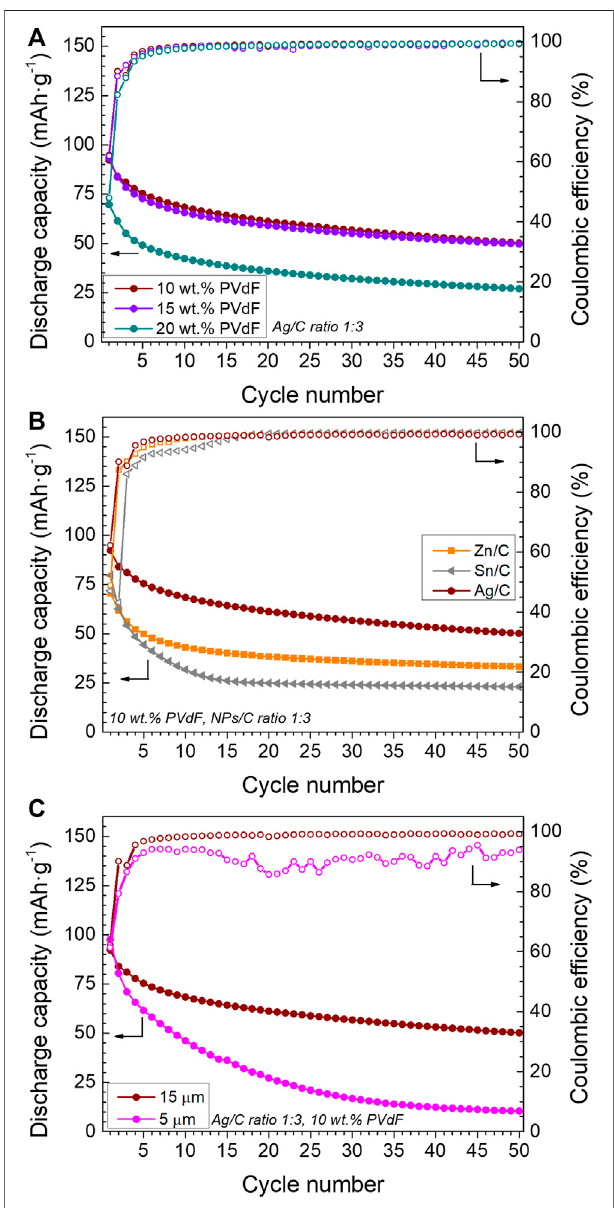
FIGURE 3 | Discharge capacity and Coulombic ef fi ciency of single-layer pouch cells using (A) Ag/C 1:3 ratio coatings with different PVdF content, (B) different metals in nanoparticles/C coatings, with 10 wt% PVdF, and NP/C ratio of 1:3, and (C) different thicknesses of Ag/C 1:3 ratio coatings with 10 wt% of PVdF. Cycling conditions: 60 ° C, 1 N m, DoD 100%, 2.5 – 3.8 V, 0.1C – 0.1C, and charge cut off current 0.05C.